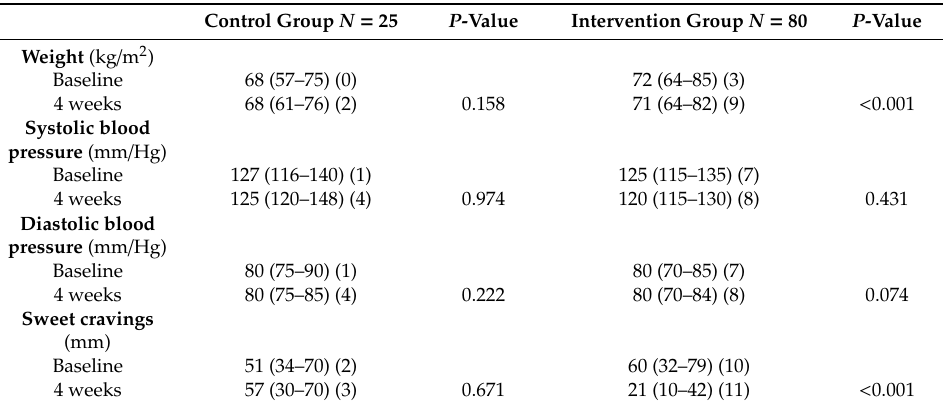
Table 3. Anthropometric data and sweet cravings in the